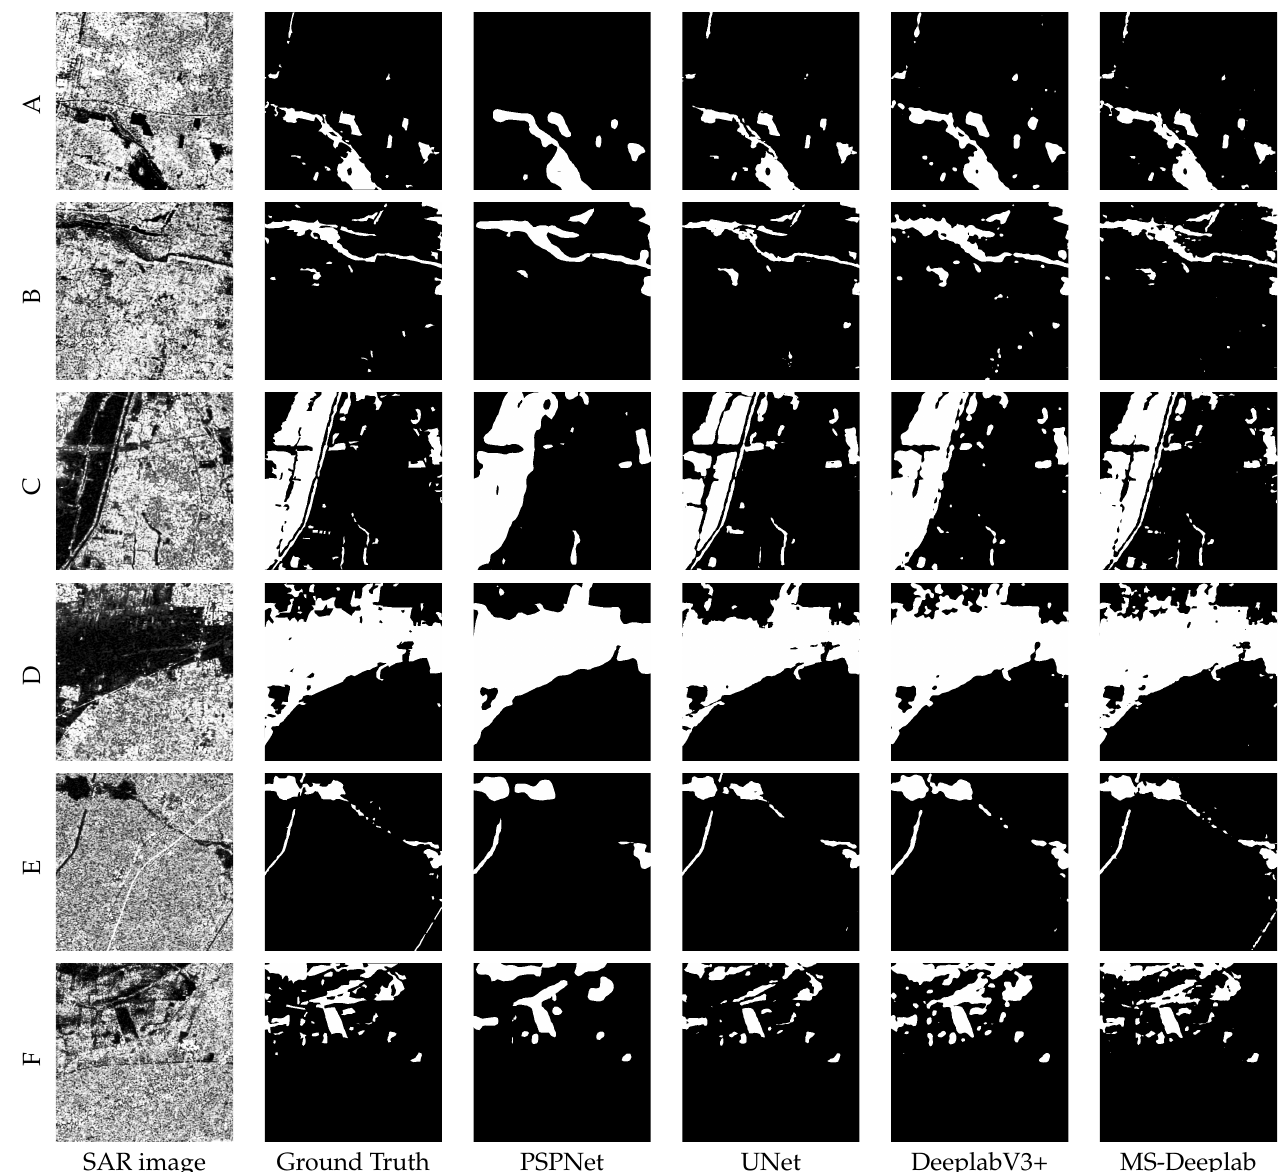
Figure 11. Comparison of the segmentation results of typical regions ( A – F ). The SAR images are enlarged versions of the regions enclosed by red rectangles in Figures 9 and 10.